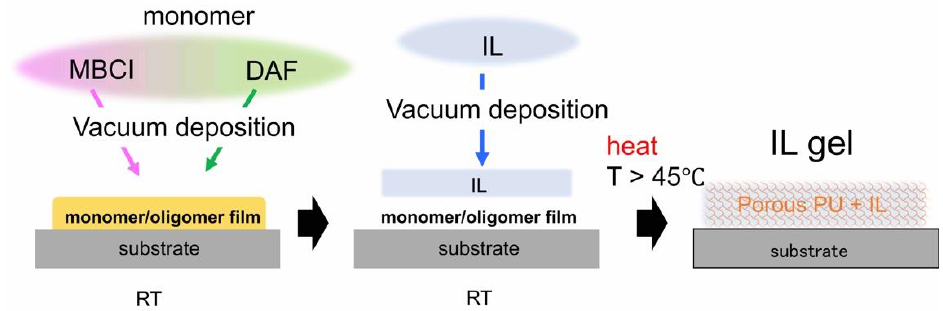
Figure 13. Schematic of the process for fabricating IL gel films.